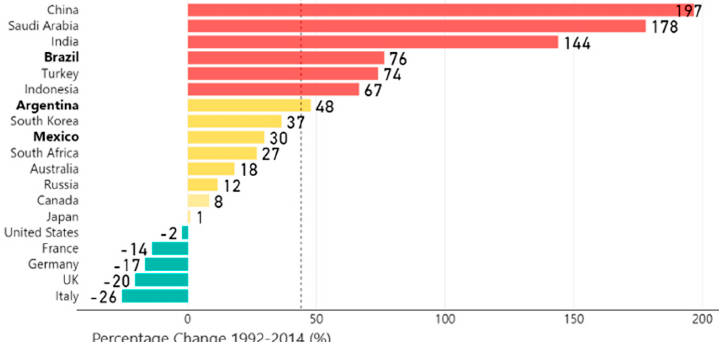
Figure 1. Percentage change in CO 2 emissions per capita within the G20 group from 1992 to 2014. We observe a dramatic increase in the newly industrialised (red), a moderate increase in emerging (yellow), and a decrease in the older industrialised economies (green). Countries from Latin America (LATAM) are in bold. Source: World Bank, 2016.